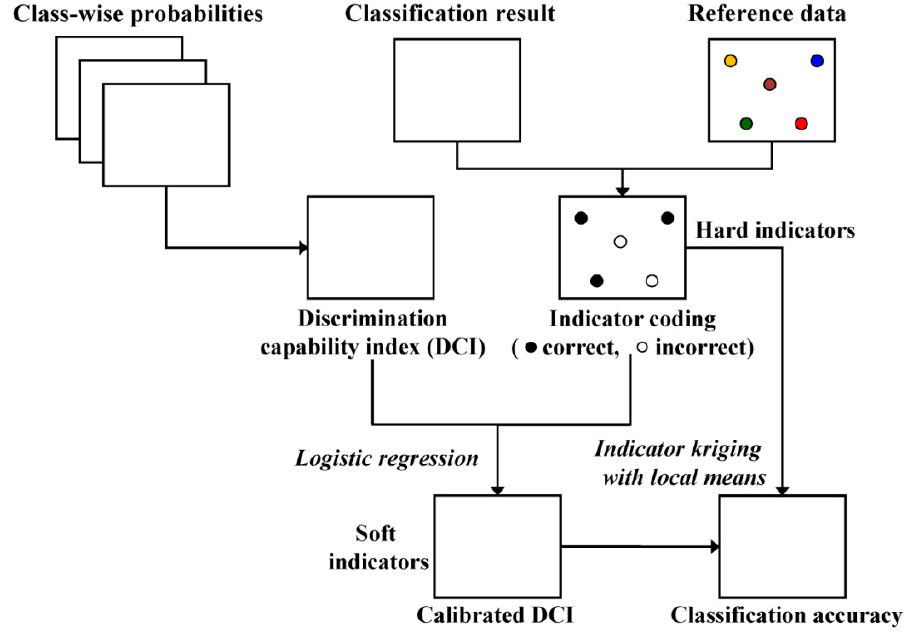
Figure 2. Flowchart of the processing steps presented in this study.